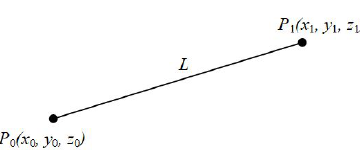
Figure 13. Rectangular parallelepiped clipping volume.